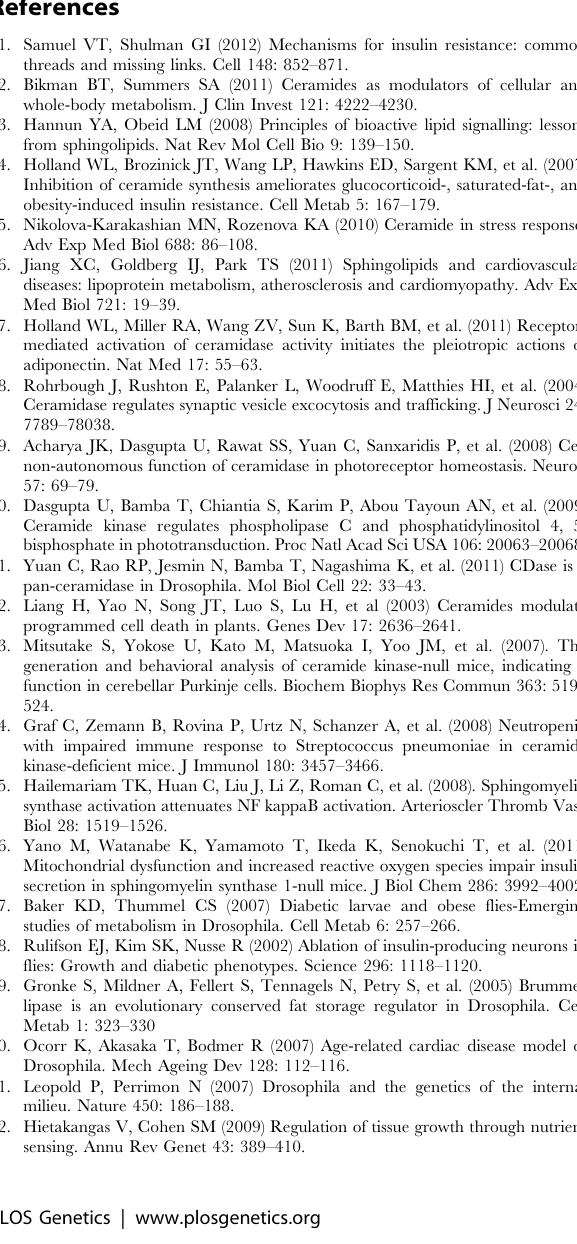
Table S2 List of candidate genes from microarray analysis that contain FOXO binding sites. The table shows genes from the microarray analysis for which potential FOXO binding sites were identified. The columns show FBgn ID with chromosome location, strand, gene start and end positions, CG numbers, peak start and end positions, distance to peak, shortest distance to peak and whether it is overlapping or nearest. Table S3 Fold change ( dcerk 1 /w 1118 ) of metabolites and their classification into different pathways. The table shows relative changes in different metabolites between control and mutant flies. The metabolites have been classified into functional pathways. A p value of 0.05 or less and q value (false discovery rate) of 0.1 or less is considered statistically significant. Text S1 Methodology detailed in Supplemental Materials and Methods. Additional details are provided for microarray analysis, metabolic assays including measurements of TAG, trehalose,